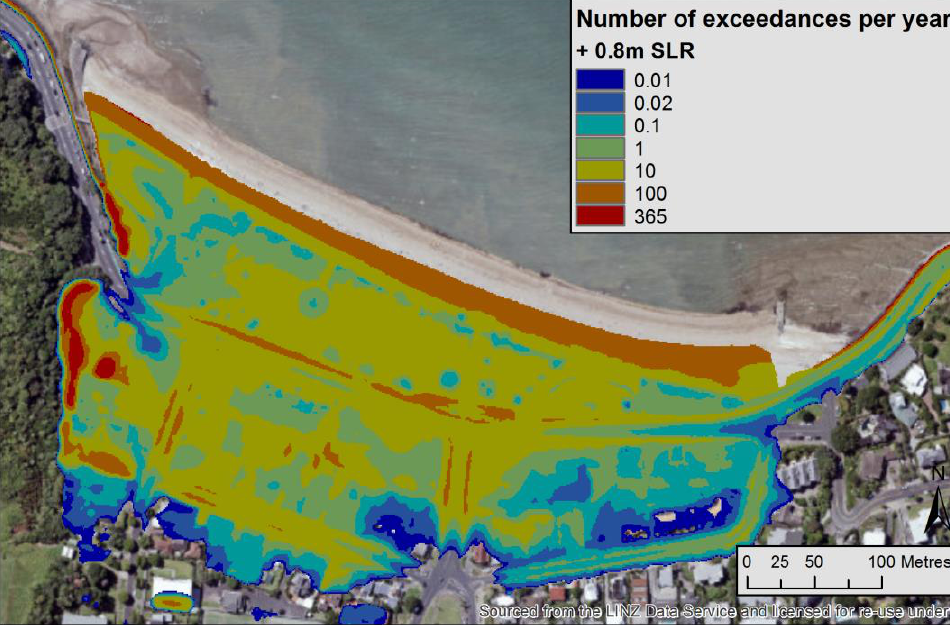
Figure 7. Frequency of flooding (exceedances per year) at Mission Bay, Auckland, for a 1% AEP storm-tide, at present-day MSL + 0.8 m SLR. Flooding was modelled using a static GIS technique. All areas below the modelled sea level are shown as inundated, regardless of connection to the sea—some inland areas may not become inundated as shown if such interconnections exist.